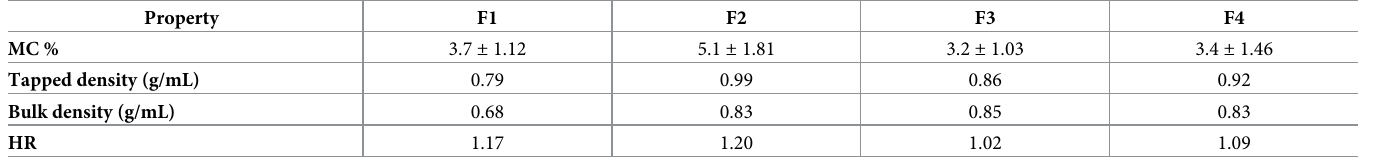
Table 5. Technological properties of proposed herbal capsule formulations. Property